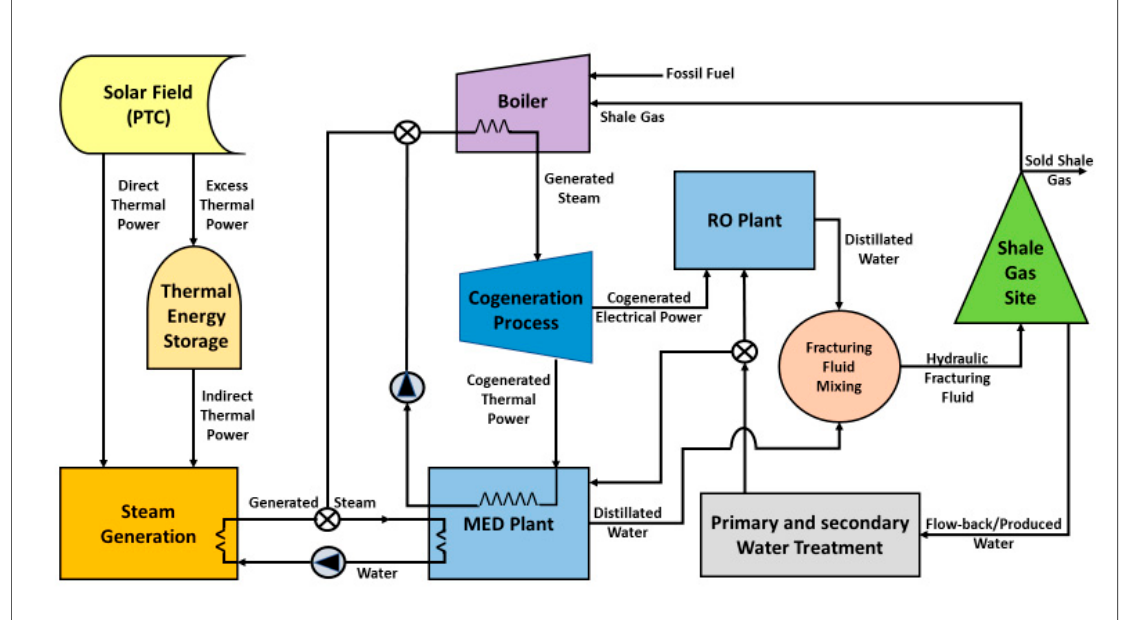
Figure 1. Proposed superstructure representation.